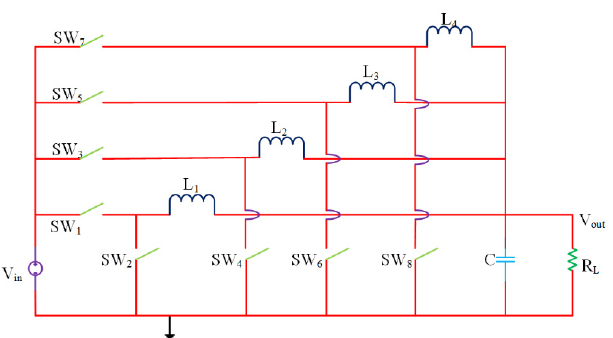
Figure 10. A four-phase buck converter [73]. Reproduced from [73], In Proceedings of the IEEE Energy Conversion Congress Exposition: 2009.